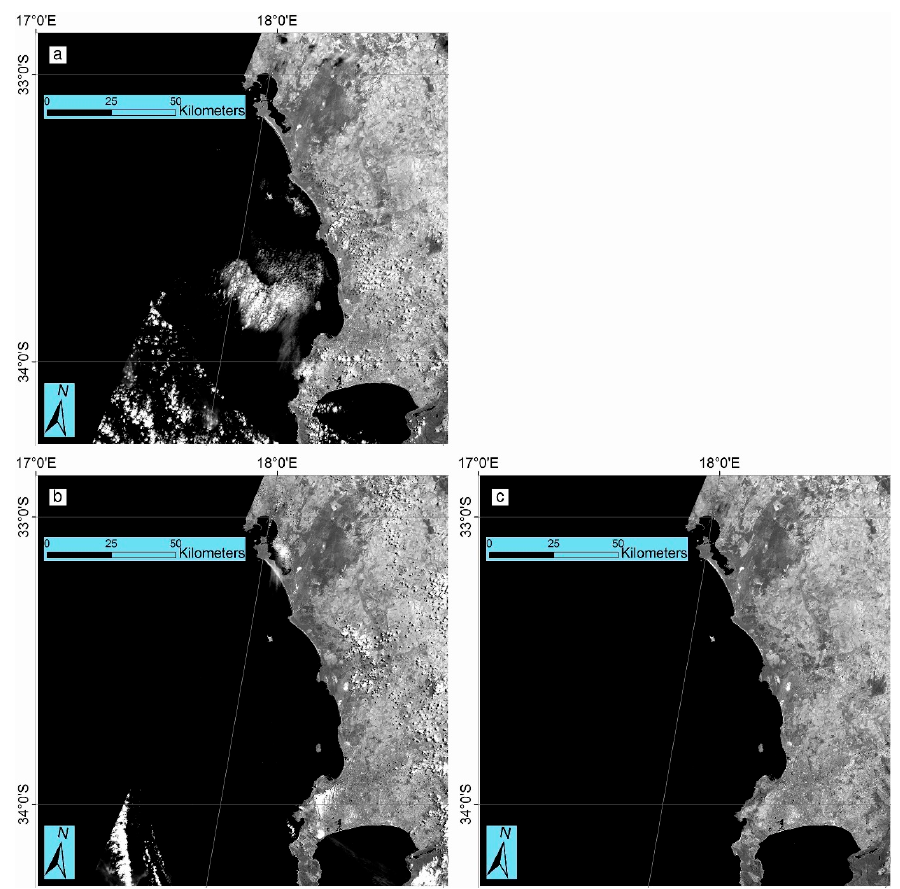
Figure 1. Cape Town, South Africa, test data showing ( a ) Landsat-8-L1T sensed 22 November 2015 (week 47); ( b ) Sentinel-2A L1C sensed 8 December 2015 (week 49); and ( c ) Sentinel-2A L1C sensed 18 December 2015 (week 51). The NIR (Sentinel-2: 842 nm and Landsat-8 864 nm band) TOA reflectance for each image is shown, which was reprojected to 10 m global WELD tile hh19vv12.h3v2 (sinusoidal projection, 15885 × 15885 10 m pixels).